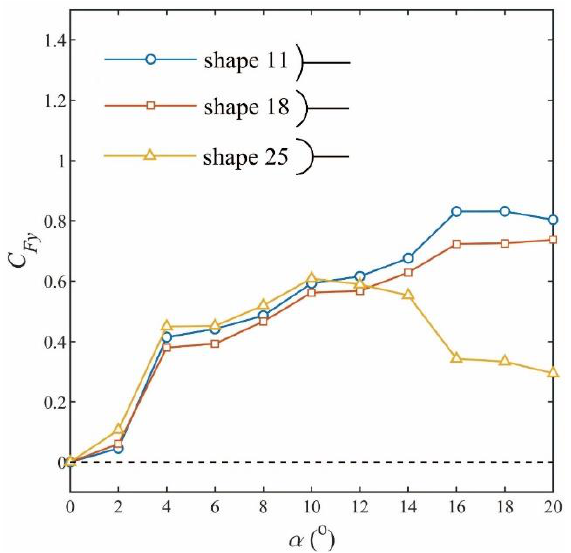
Figure 13. Variation of transverse force coefficient C Fy with wind attack angle α for bluff bodies with excellent vibration performance.